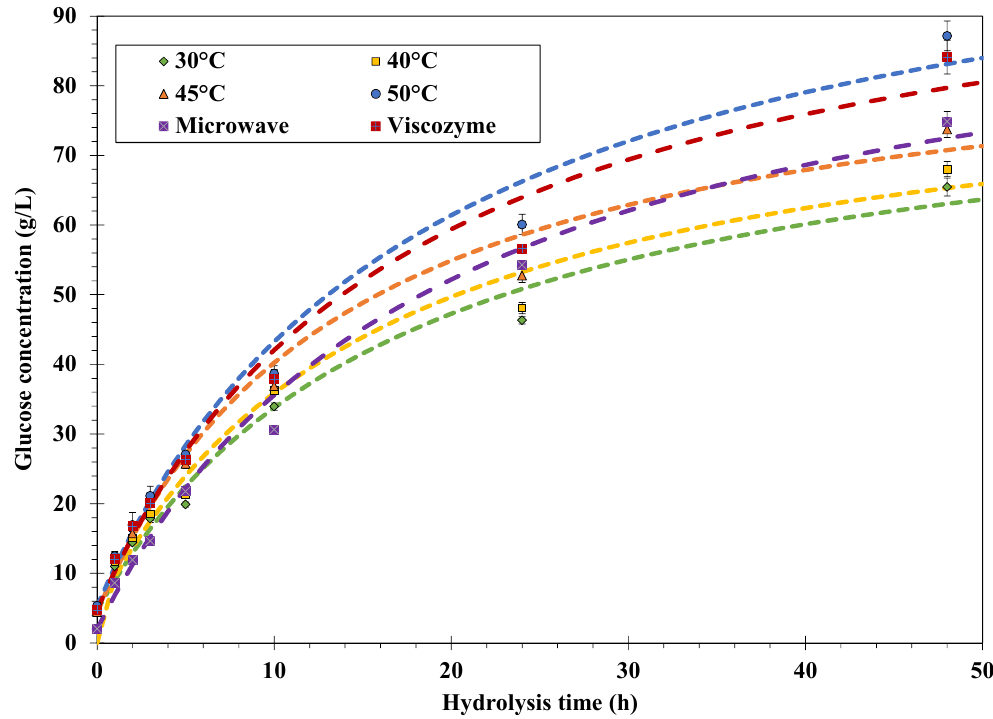
Table 1. Hydrolysis yield after 48 h of hydrolysis.